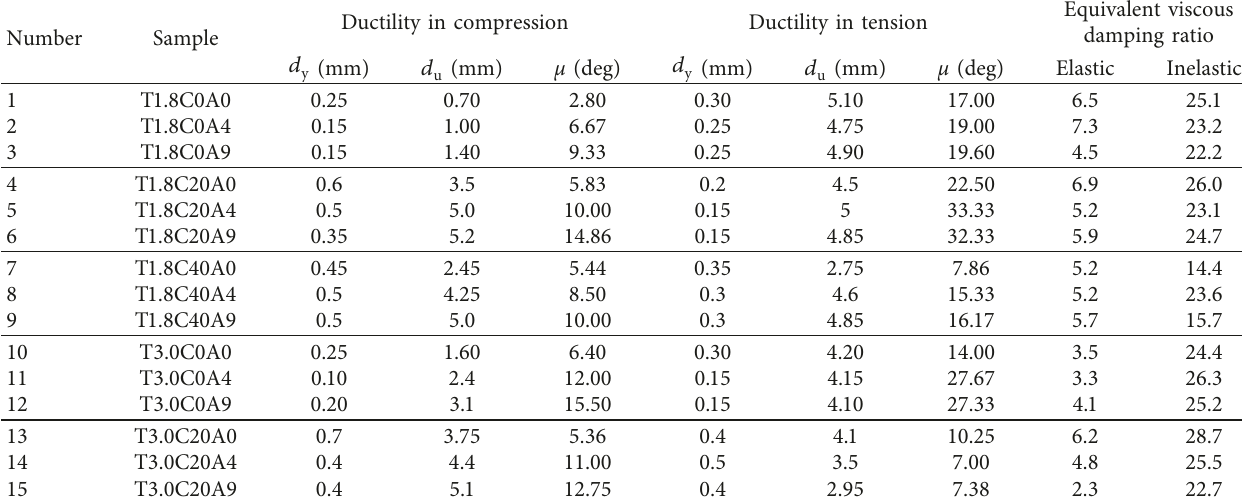
Table 2: Ductility factor and equivalent viscous